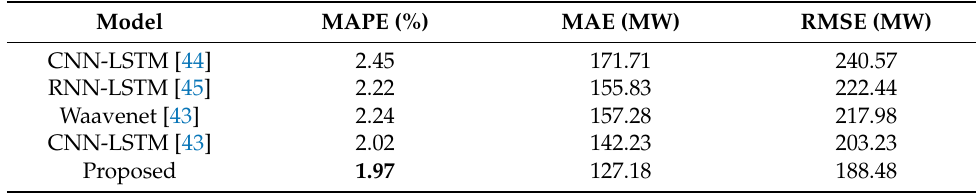
Table 6. MAPEs of the proposed model with the ENSTO-E